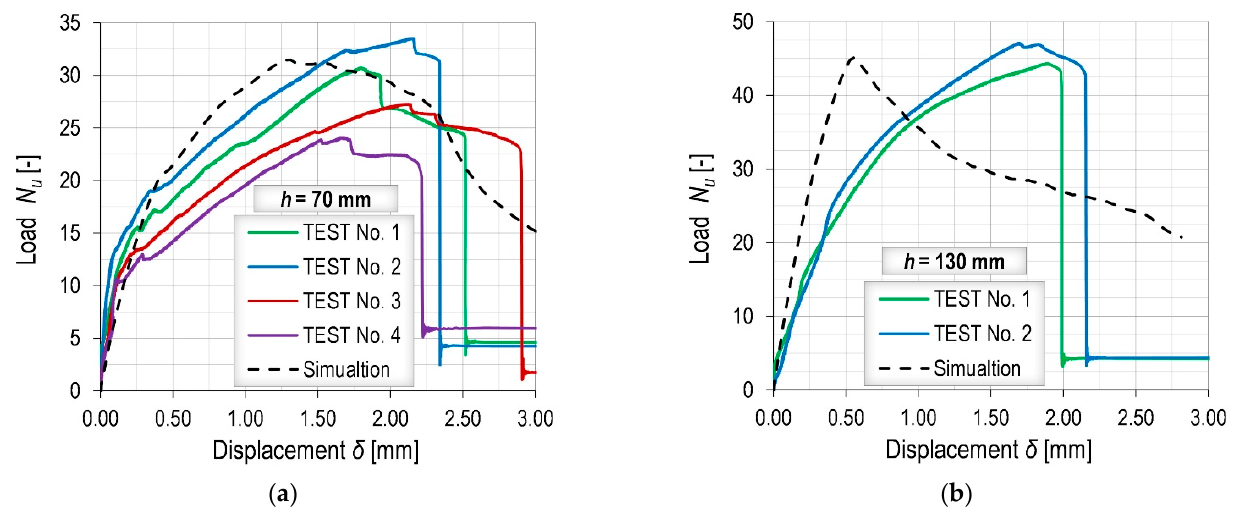
7 of 21 Figure 3. Comparison between experimental and numerical breakout patterns for: ( a ) plain concrete slab; ( b ) composite slab. Table 3. Comparison between experimental and numerical results—4 tests were performed for each configuration. Slab Type